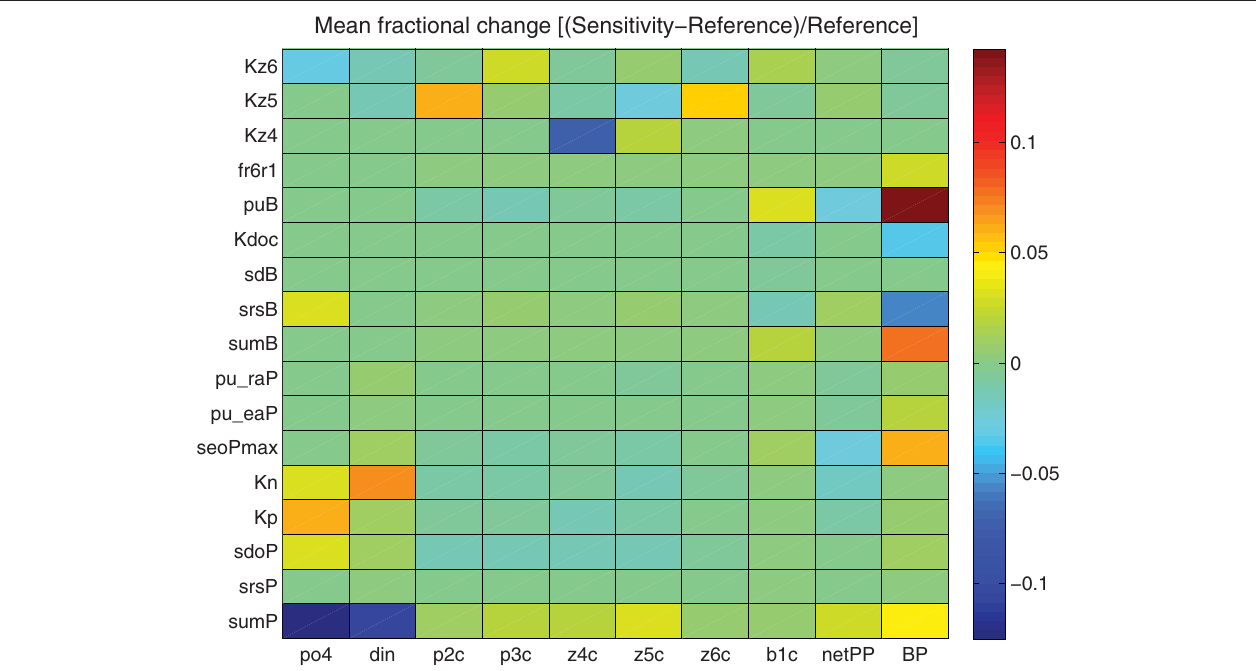
FIGURE 11 | Mean fractional change [(Sensitivity − Reference)/Reference) of model simulated PO 4 , DIN, nanophytoplankton (p2c), picophytoplankton (p3c), mesozooplankton (z4c), microzooplankton (z5c), HNAN (z6c), bacteria (b1c), net primary production (netPP), and bacterial production (BP) adopting a 10% increase of different model parameters (see Tables A1, A2 in Supplementary Material for their definition and reference